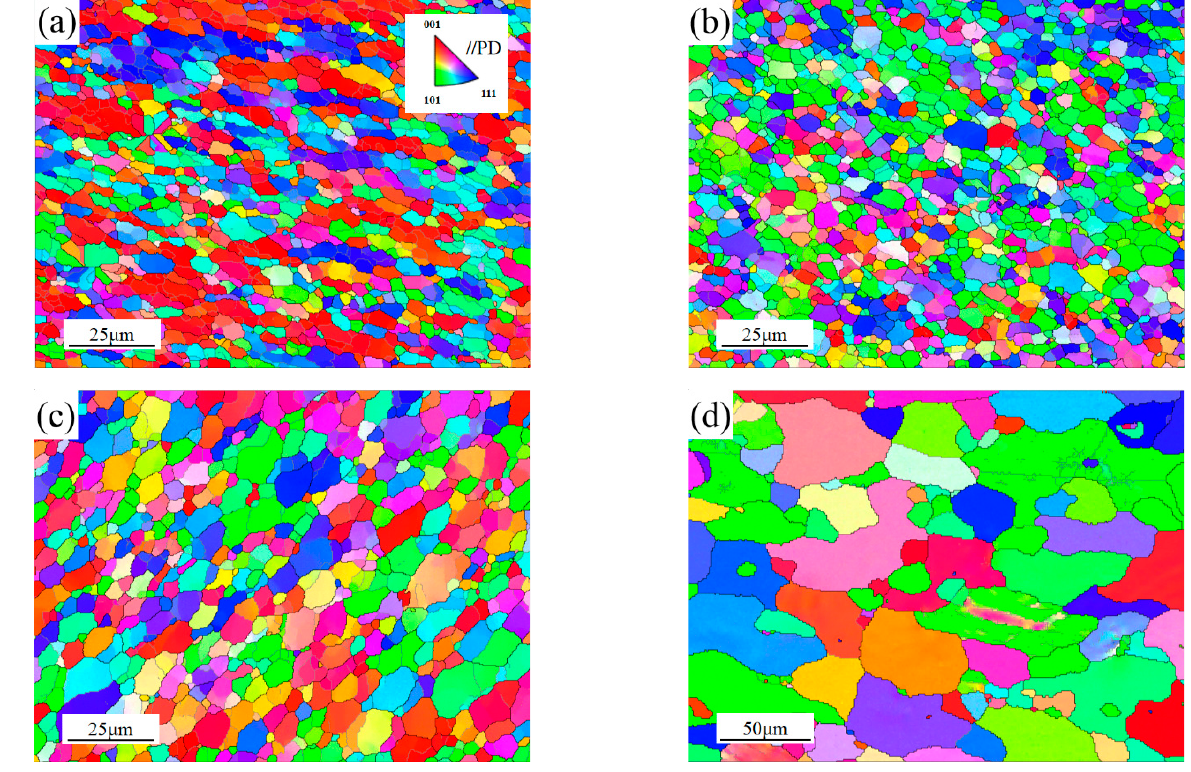
Figure 4. Grain morphology maps of SZ ( a ) SZ-1; ( b ) SZ-2; ( c ) SZ-3 and ( d ) BM.